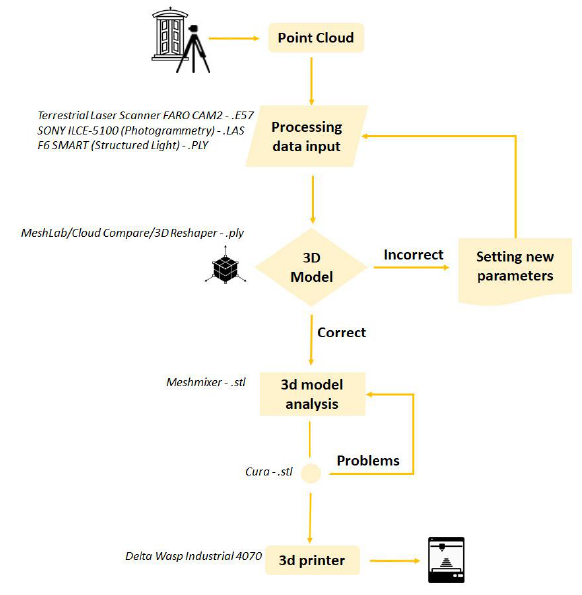
Figure 16. Process for data restitution.